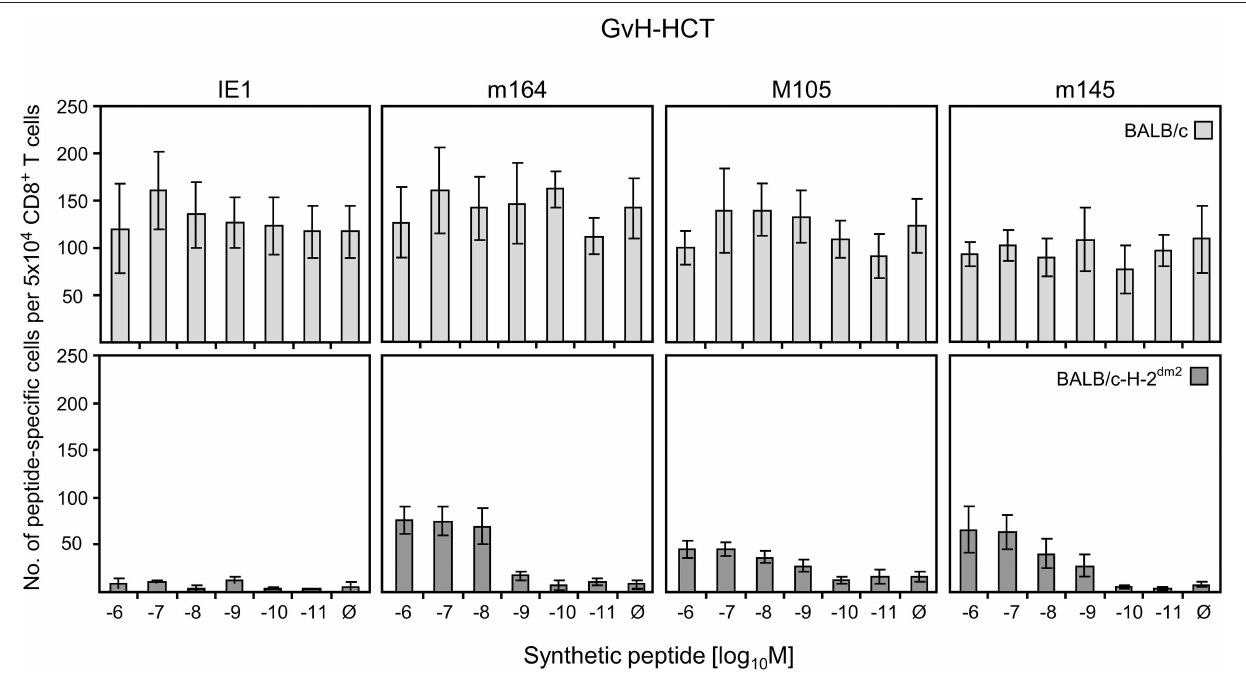
FIGURE 6 | Quantitation of GvH-reactive and viral epitope-specific liver-infiltrating CD8 + T cells after GvH-HCT. Liver-infiltrating CD8 + T cells were isolated from liver tissue (yield from 10 livers) of infected GvH-HCT recipients on day 20. Their functional activity was tested in an ELISpot assay based on IFN γ secretion in response to stimulation with BALB/c (upper panels) or BALB/c-H-2 dm2 (lower panels) MEF as target cells that were exogenously loaded with graded loading-concentrations of the indicated synthetic viral peptides to reveal cumulative avidity distributions. Effector cells responding at a certain peptide concentration include cells that respond to concentrations < the indicated concentration. Ø, no viral peptide loaded. Error bars represent 95% confidence intervals determined by intercept-free linear regression.